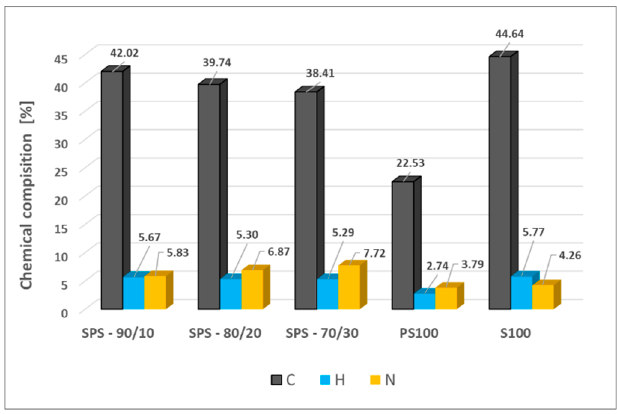
Figure 2. Proximate analysis of produced samples compared to wheat straw (S100) and paper sludge pellets (PS100).